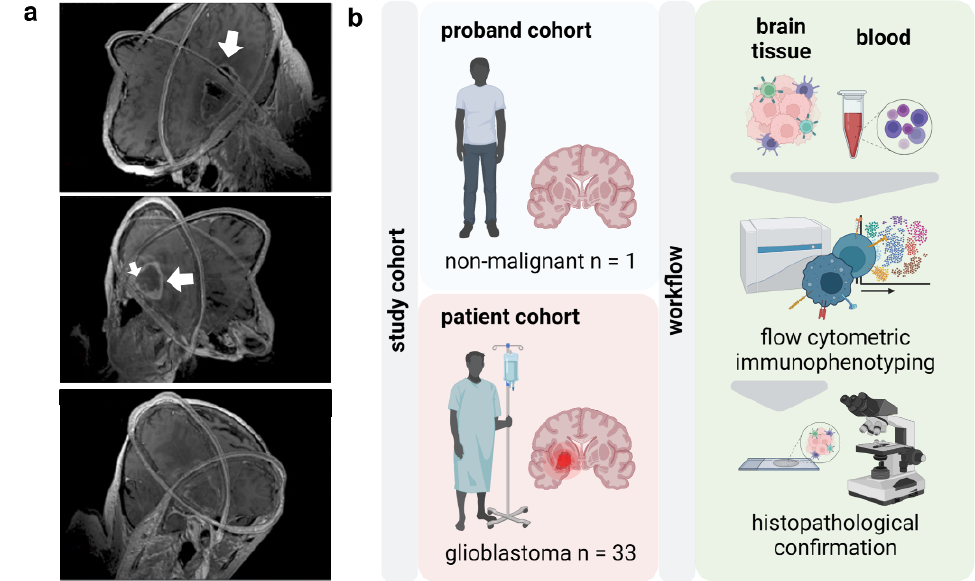
Figure 1. Study overview. ( a ) 3D visualizations of MRI scans of glioblastoma (white arrows) patients reconstructed from axial, sagittal, and coronal slices; ( b ) study overview. Table 1. Overview of patient and proband cohorts . Summary of GBM patient and proband cohorts used for flow cytometric immunophenotyping in this study. N.A.: not applicable. IDH: isocitrate